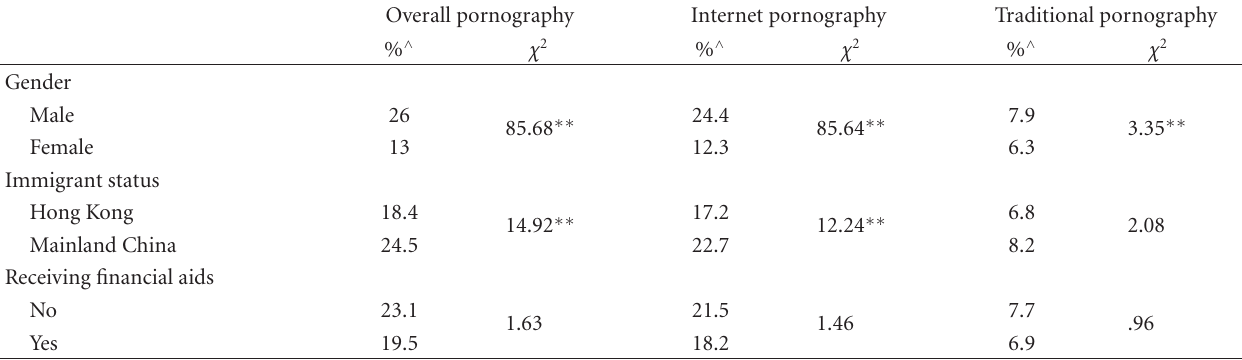
Table 5: The Chi-square test of independence among di ff erent types of pornographic materials by gender, immigrant status, and family economic background.